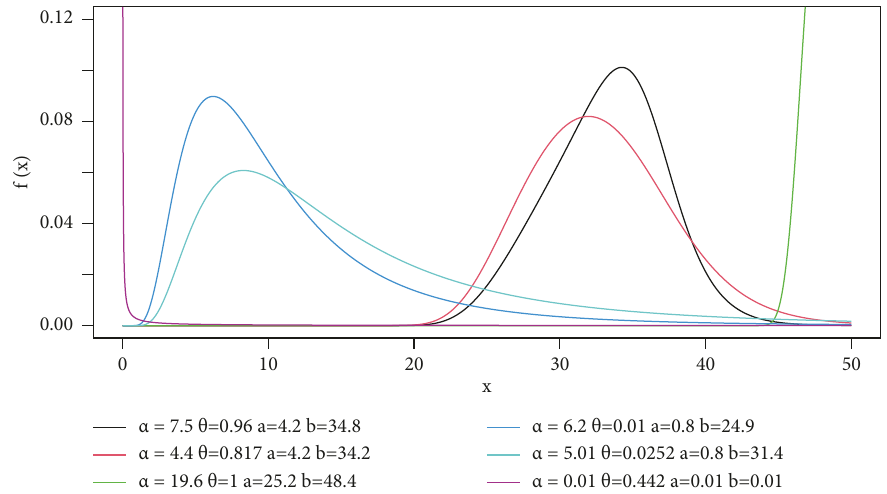
Figure 1: PDF plot of the HMF